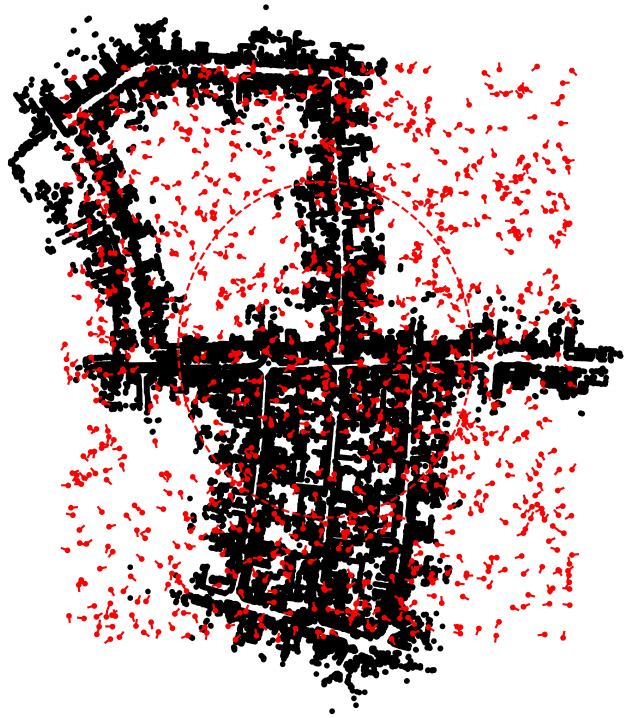
Figure 7. Snapshot at k = 0 with particles shown as red dots. The red dots correspond to possible vehicle positions and the corresponding red line − segment from each dot represents the heading of the